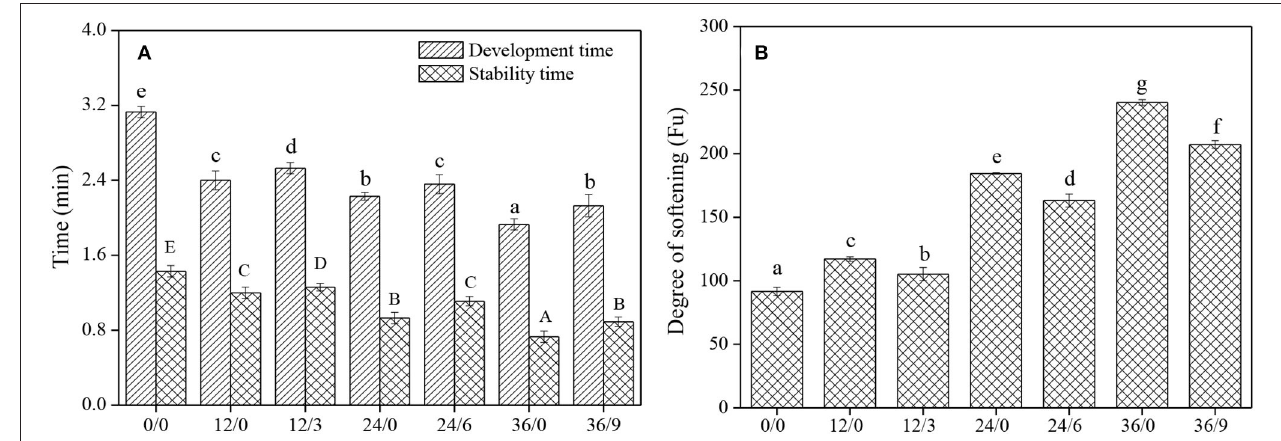
FIGURE 6 | The development time, stability time and degree of softening of whole wheat flours during germination under UV-B radiation. Different letters indicate the results of Duncan’s multiple range test at 5% level of significant difference among different germination and UV-B radiation time, respectively.